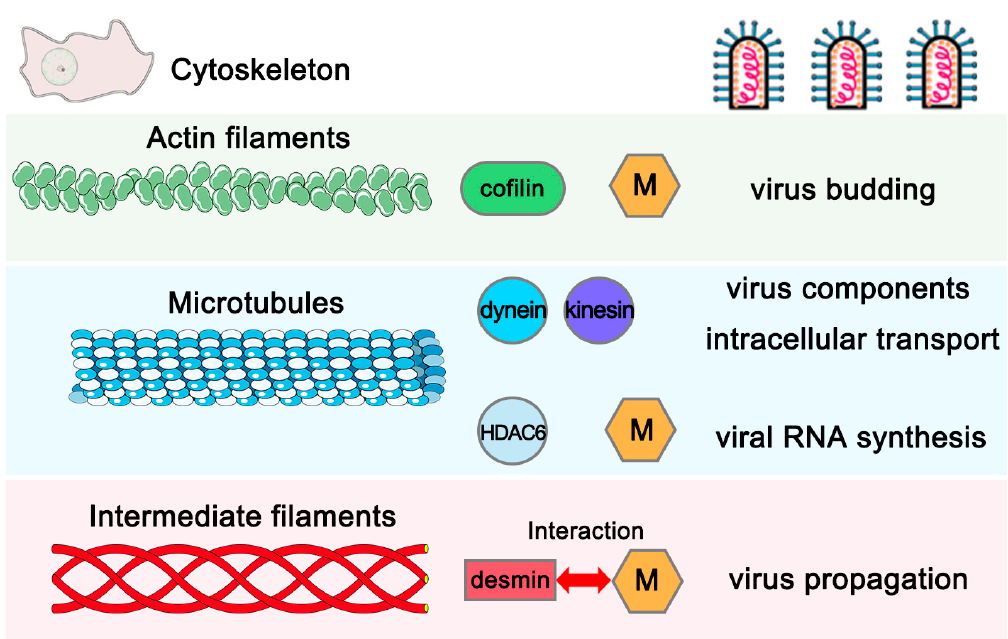
Figure 6. Graphical abstract illustrating that RABV-M exploits host proteins and cytoskeleton com- ponents to facilitate RABV infection. While the RABV utilizes cofilin and actin filament for efficient M-mediated virus budding, the M protein regulates HDAC6 expression and microtubule depoly- merization to enhance viral RNA synthesis. Here, we report a novel physical and functional inter- play between RABV-M and intermediate filament protein desmin that promotes RABV propaga- tion.